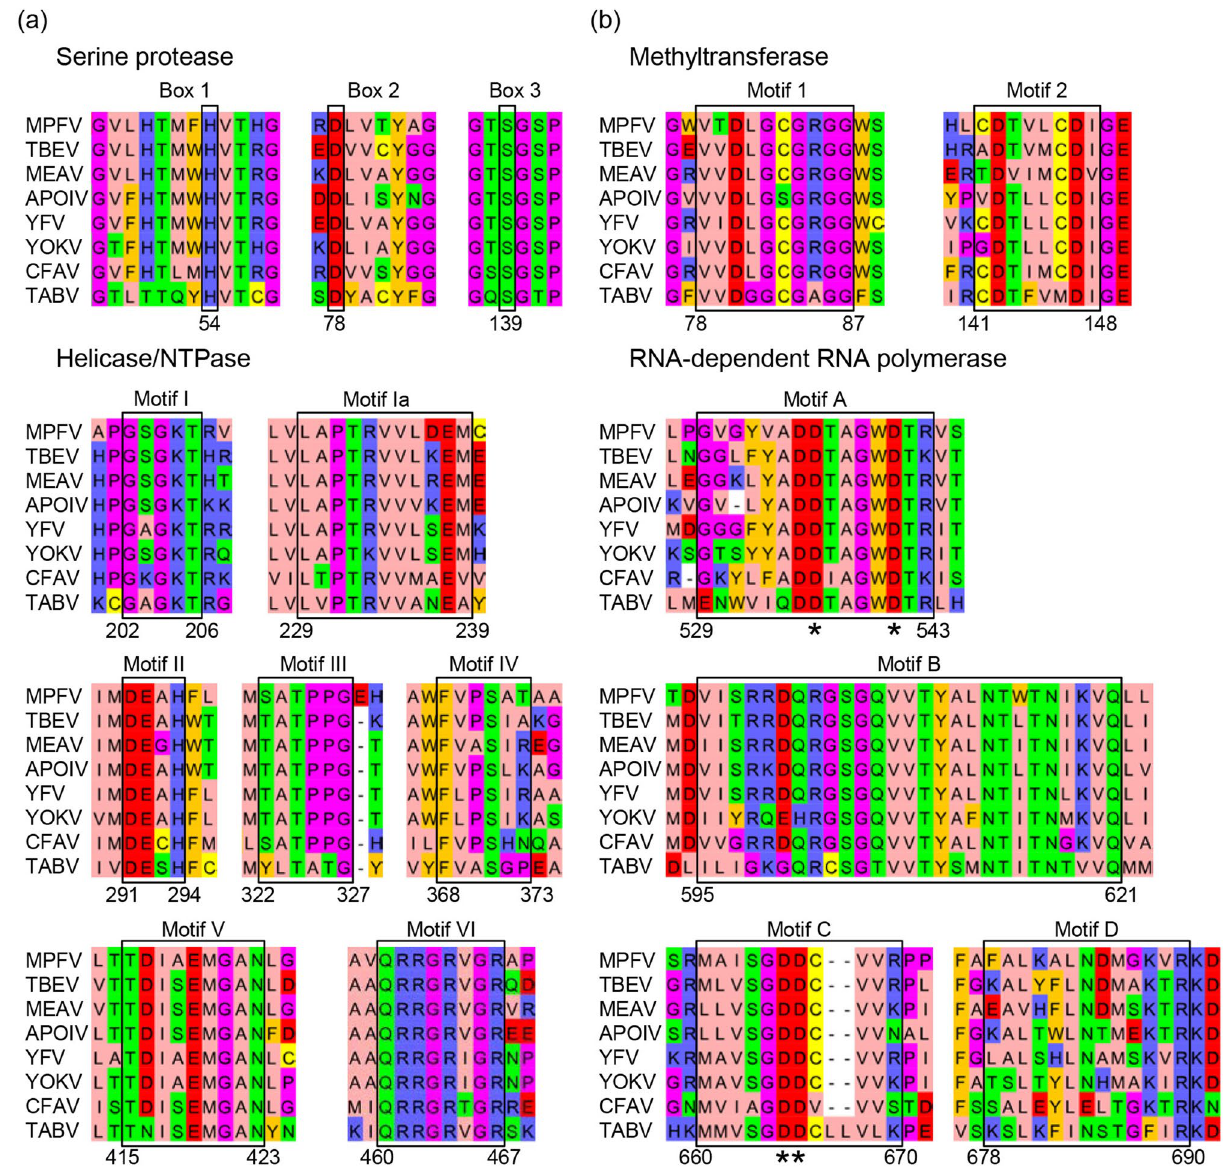
Figure 1. Conserved enzymatic motif in the serine protease, helicase/NTPase, methyltransferase, and RdRp. Sequence alignments of NS3 ( a ) and NS5 ( b ) from MPFV and representative flaviviruses were constructed. Enzymatic motifs are delimited accordingly. ( a ) The N-terminus and the C terminus of NS3 contain the serine protease and helicase/NTPase, respectively. The catalytic triad of serine protease (Box 1–3) and seven conserved motifs of helicase/NTPase (Motifs I–VI) are highlighted. ( b ) The N terminus and the C-terminus of NS5 contain methyltransferase and RdRp, respectively. The two (1 and 2) and four (A–D) conserved motifs of methyltransferase and RdRp are highlighted. Asterisks indicate conserved aspartic acid residues, which are important for enzymatic activity. Numbers at the bottom of the alignments refer to the MPFV sequence. Abbreviations of virus names are as follows: MPFV Mpulungu flavivirus, TBEV tick-borne encephalitis virus, MEAV Meaban virus, APOIV Apoi virus, YFV Yellow fever virus, YOKV Yokose virus, CFAV cell fusing agent virus, TABV Tamana bat